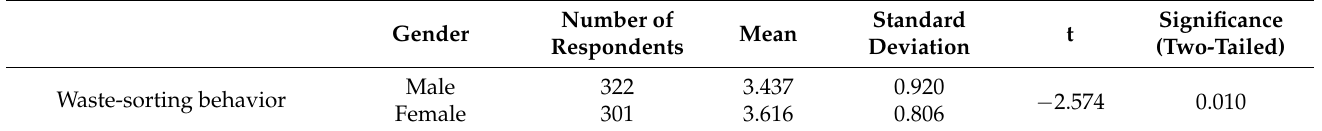
Table 13. Results of the test for differences in waste-sorting behavior between the male and female respondents.